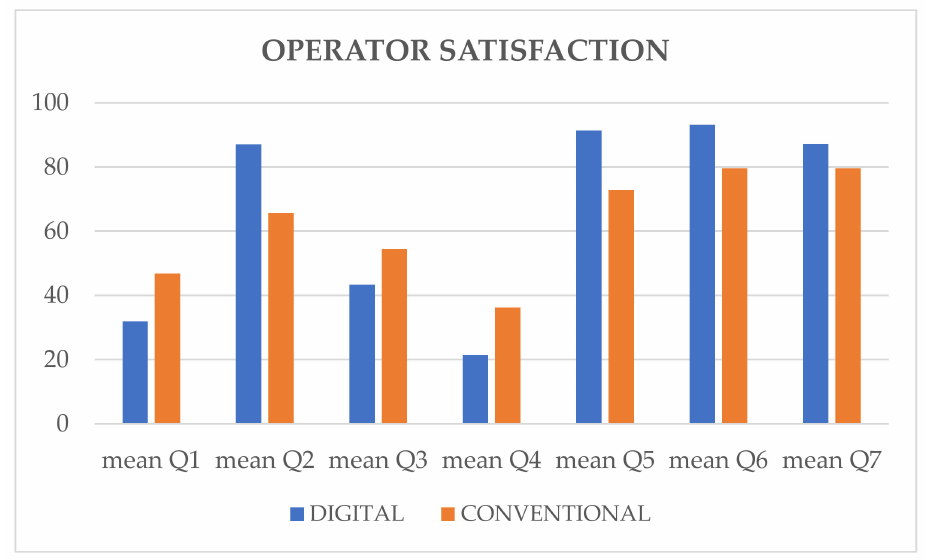
Figure 6. Mean scores of operator-centered outcomes with digital and conventional protocol. Table 2. Questions on operator satisfaction with digital and conventional protocol and mean scores of the